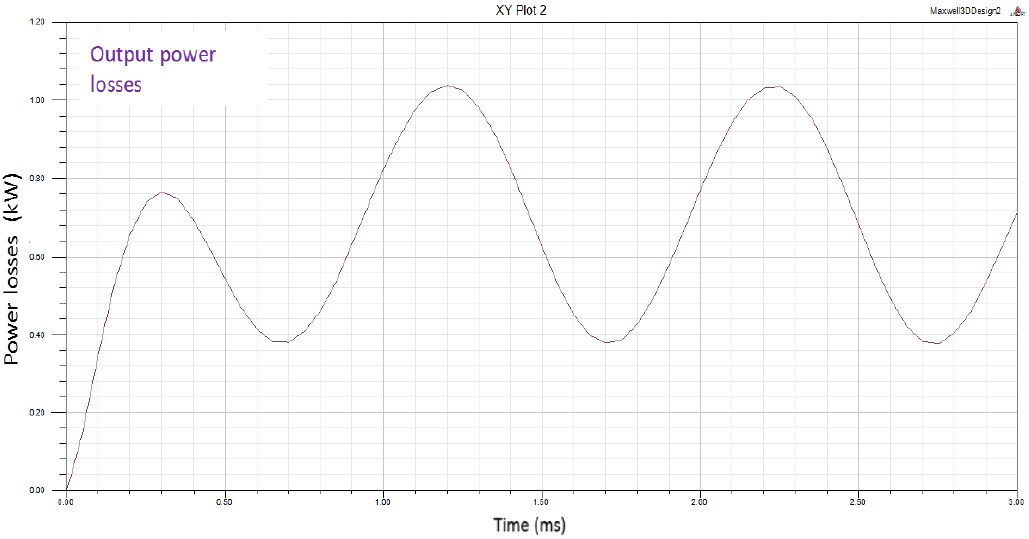
Figure 5. Power loss in torque limiter mode.